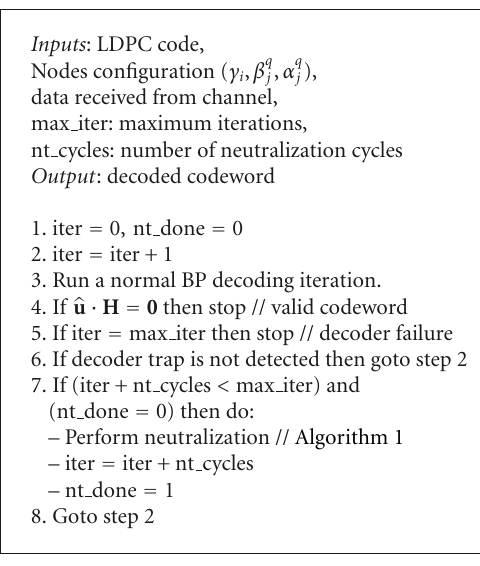
Algorithm 4: The proposed learning-based